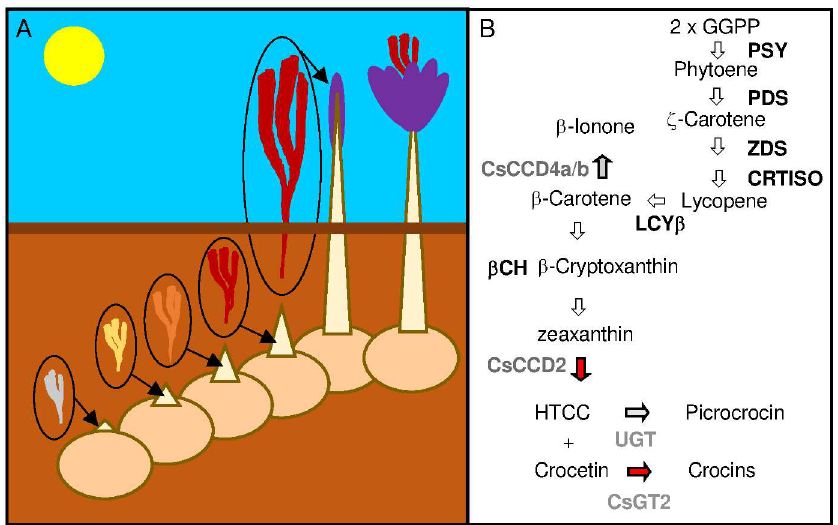
Fig 1. Flower development in saffron and apocarotenoids biosynthesis in the stigma tissue. (A) Drawingrepresenting the developmental steps of flower development in saffron. At the beginningof September, one or more shoots emergefrom the underground corm with the undevelopedflowers and leaves wrappedby the cataphylls, as flower developsthe cataphyllgrows protecting the flower up to the moment of shot emergence from the soil, which takes place duringOctober-November, when the flower is complete developed. (B) Schematic representation of the apocarotenoidbiosynthetic pathway in saffron stigma. Enzymatic reactionsare representedby arrows. GGPP, geranyl geranyl diphosphate; PSY, phytoene synthase; PDS, phytoenedesaturase; ZDS, Ϛ -carotenedesaturase; CRTISO, carotene isomerase;LCY β , lycopene β -cyclase; β CH, β -carotenehydroxylase; HTCC, 2,6,6-trimethyl-4-hydroxy-1-carboxaldehyde- 1-cyclohexene.